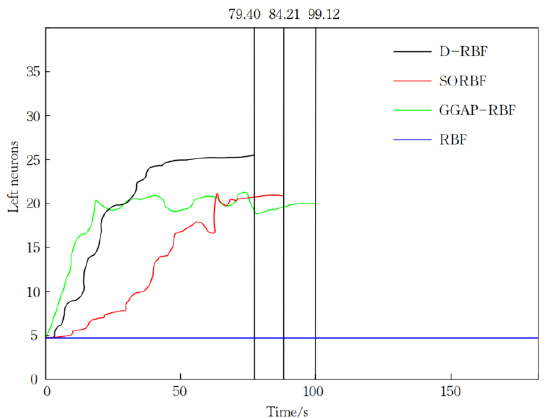
Figure 14. The number of neurons in hidden layer during network training.